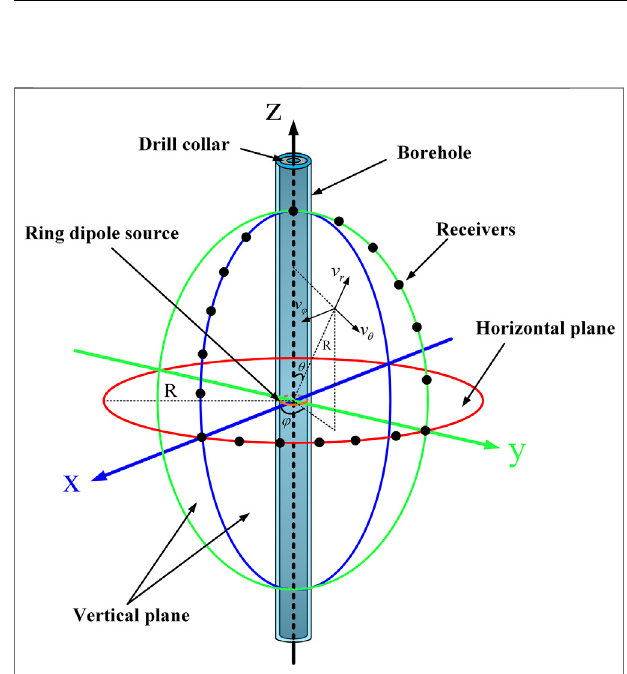
FIGURE 6 | The Schematic diagram of the dipole source radiation patterns in LWD